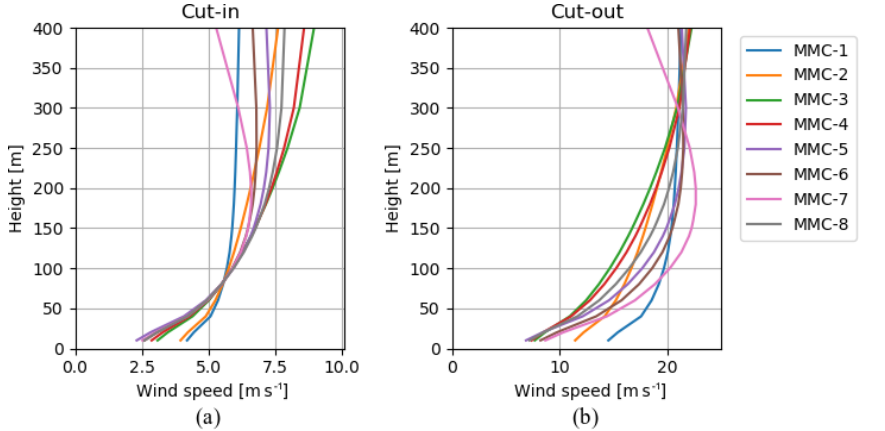
Figure 18. The cut-in (a) and cut-out (b) wind profiles that follow from scaling the onshore profile shapes in Fig. 12 (Sect. 4.3) using the calculated cut-in and cut-out wind speeds at 100m, respectively.